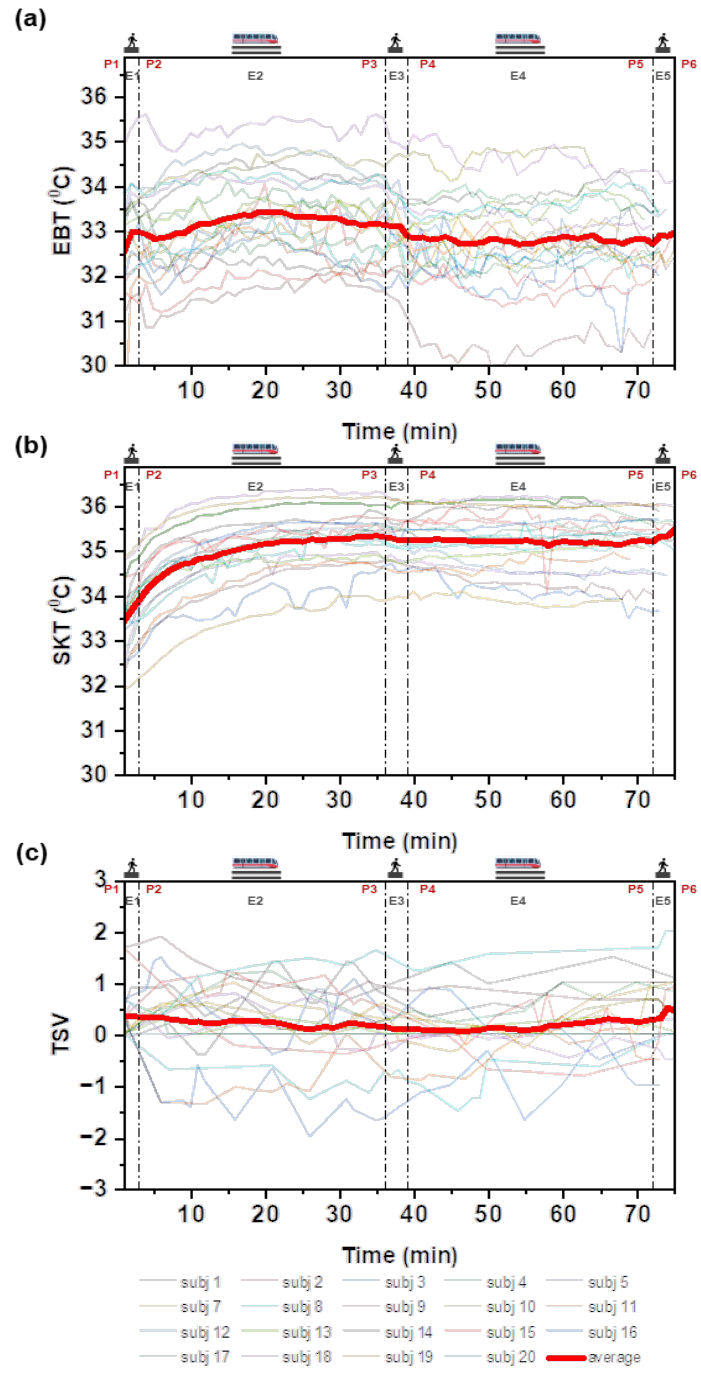
Figure 7. Average transient ( a ) EBT, ( b ) SKT, and ( c ) TSVs for each participant.